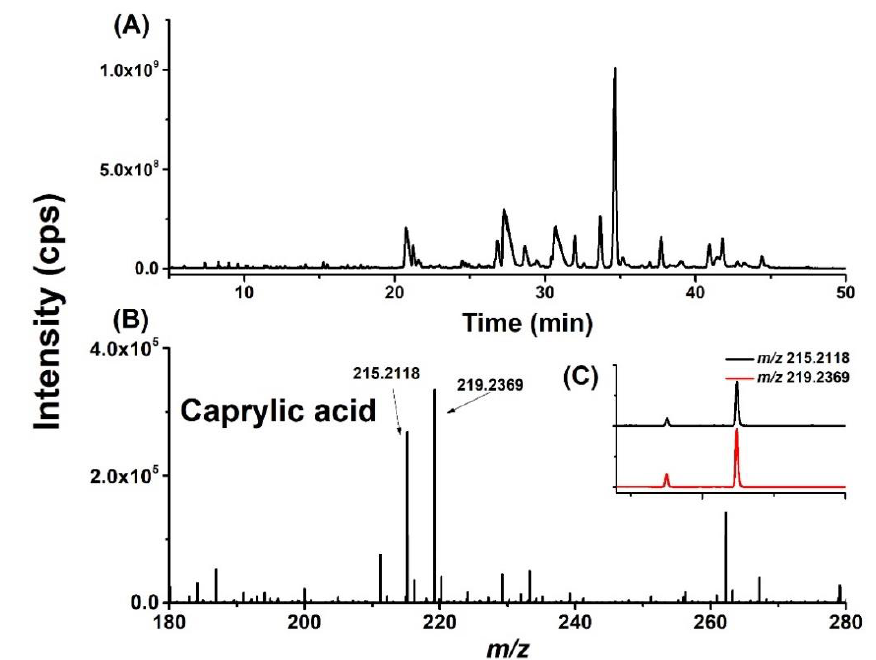
Figure 1. An example for the steps of identification of metabolites in brain extracts with the chemical isotope-labeled method using LC-MS under the full scan mode. ( A ) Total ion chromatograms (TIC) of the DMED / d 4 -DMED-labeled brain sample. ( B ) Mass spectra of DMED / d 4 -DMED-labeled caprylic acid. ( C ) Extracted ion chromatograms (EIC) of caprylic acid at m / z 215.2118 and 219.2369 from DMED / d 4 -DMED-labeled brain sample.